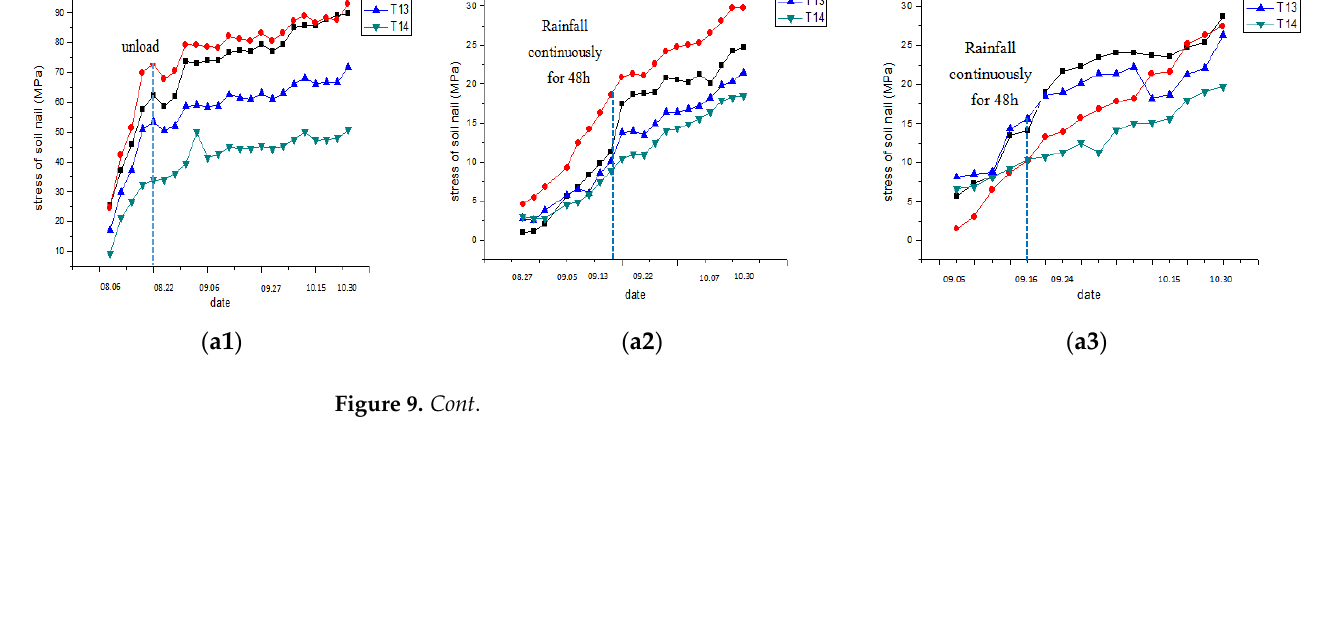
Figure 8. Location of instruments for No. 5.